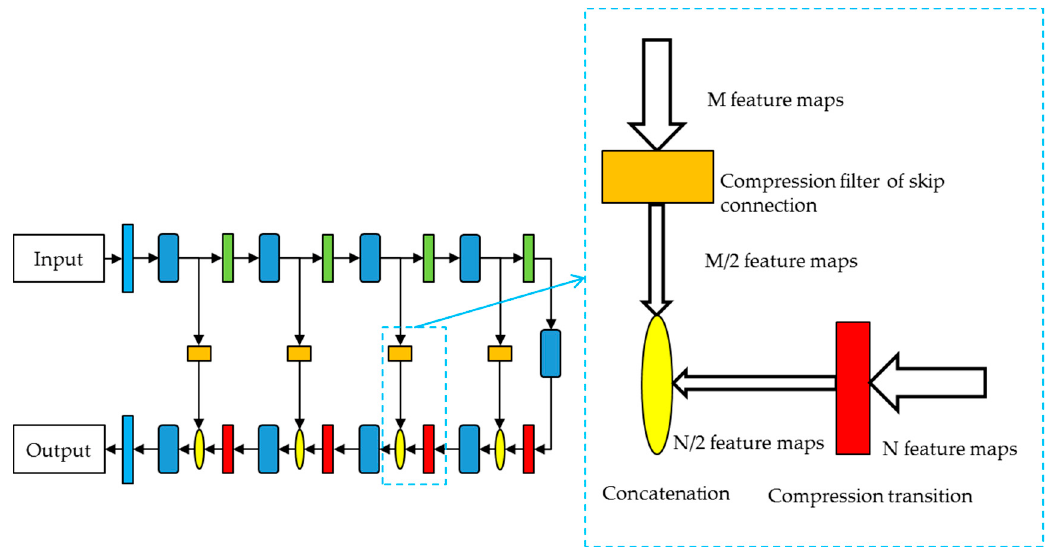
Figure 4. An illustration of our proposed compression filter in skip connections and the compression transition in the decoder. The orange block represents the compression filter in the skip connection, and the red block refers to the compression transition in the decoder.